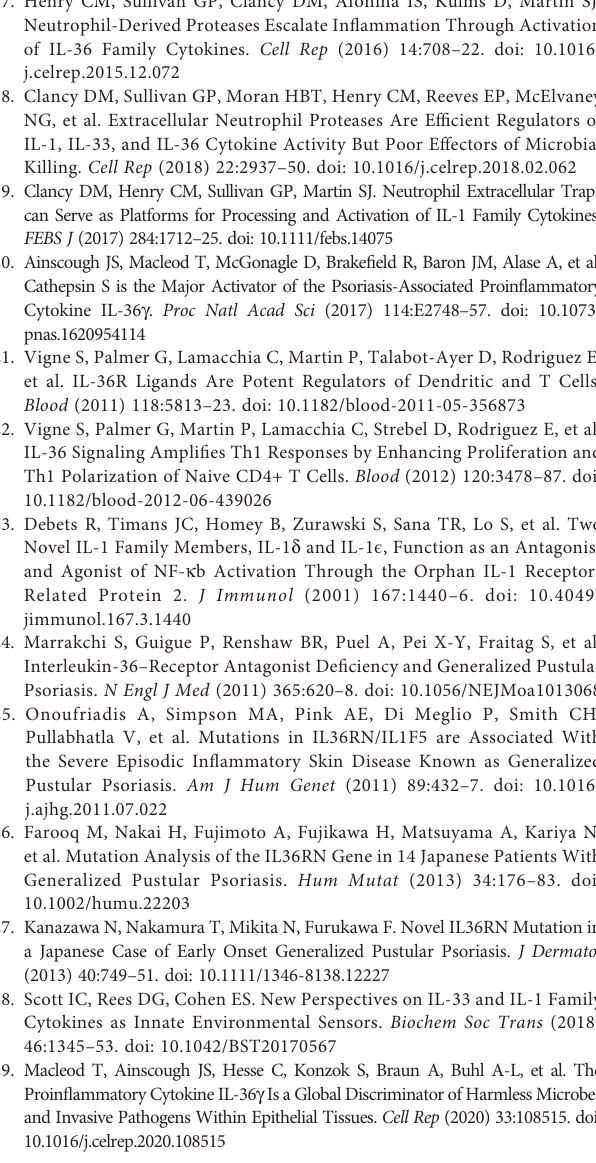
Supplementary Figure 1 | Puri fi cation of wild-type IL-36 b and IL-36 b point mutants. (A) SDS-PAGE analysis of human recombinant full-length wild type IL- 36 b , IL-36 b R5A and IL-36 b Q4A mutants. Supplementary Figure 2 | IL-36 b point mutants resist activation by speci fi c allergens. HeLa IL-36R cells were stimulated with 2 nM of wild type human recombinant full length IL-36 b , IL-36 b R5A , or IL-36 b Q4A , either untreated, or pre-incubated for 2 h at 37°C with a titration of 40, 20 and 10 m g/ml of extract from Cockroach (A) HDM (B), 1:2000, 1:10000 and 1:20000 dilutions from a stock of puri fi ed protease from A. oryzae (D) or 1, 0.5 and 0.01 m g/ml of B. licheniformis extract (D). As a control, either wild type recombinant full length IL-36 b , IL-36 b R5A and IL-36 b Q4A cytokines were activated with 50 nM of cathepsin G. After 24h, IL-8 cytokine concentrations in cell culture supernatants were measured by ELISA. Error bars represent the mean of triplicate determinations from representative experiments. ***p < 0.0001, **p < 0.001, *p < 0.1, Student ’ s t